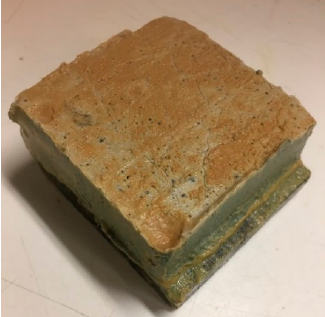
Figure 8. Specimens after the direct shear experiment (treated for 1 day; initial sulfate concentration of 25,000 mg/L; made with 0.3% fibers; normal stress of 50 kPa). Comparison of Figure 7a,b reveals that the specimens with 0.3% fibers generally have less shear contraction than the specimens without fibers, and the sulfate ‐ free specimens with 0.3% fibers exhibit some dilatation. This is because some of the voids or capillary pores in the CPB matrix are filled by the fibers, leading to an optimized pore structure. Therefore, the rearrangement of the fibers and the settlement of the CPB particles are restrained and, thus, less compressibility is observed on the macroscopic level [56]. The slight dilatancy mentioned above is caused by the relative movement of the asperities on the interface. Although only cured for 1 day, the specimens without sulfate still have a larger amount of hydration products than the sulfate containing specimens [28]. Figure 9 shows the evolution of the shear stress and shear displacement and the vertical displacement and shear displacement of the FR ‐ CPB/rock interface specimens with various sulfate concentrations (cured for 1 day; CPB made with 0.3% fibers) under a normal stress of 150 kPa. Comparison of the results shown in Figures 5b and 7b, and Figure 9 reveals that irrespective of the initial sulfate concentration, the specimens subjected to a higher normal stress (150 kPa) have higher shear stresses and larger shear contraction than those subjected to a low normal stress (50 kPa), and no evidence of shear dilatancy was observed. This is because a higher normal stress will enlarge the contact area between the CPB particles and the granite and between the fibers and the granite. Accordingly, more friction is generated between the FR ‐ CPB matrix and the rock, and thus, the shear stress is increased [26]. The larger shear contraction can be explained by the significantly reduced porosity and the greater compressibility of the specimens treated for a short time (1 day) when subjected to a higher normal stress. Moreover, the asperities and the larger CPB particles on the shear plane, which are still very weak due to the short curing time, can be easily destroyed or crushed under a higher normal stress, and thus the shear dilatancy is contained [20]. ( a ) ( b ) Figure 9. Shear properties of the specimens with various initial sulfate concentrations under a normal stress of 150 kPa (treated for 1 day; CPB made with 0.3% fibers). ( a ) shear stress vs. shear displacement. ( b ) vertical displacement vs. shear displacement.